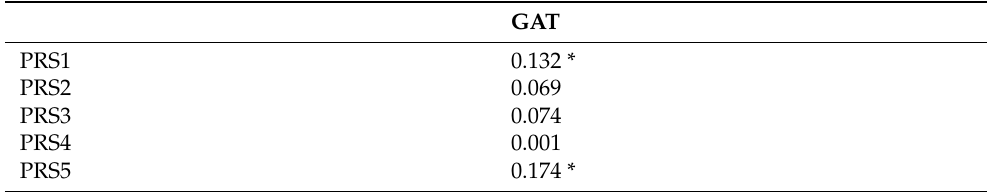
Table 4. Correlation between product-related services and gross annual turnover (GAT).